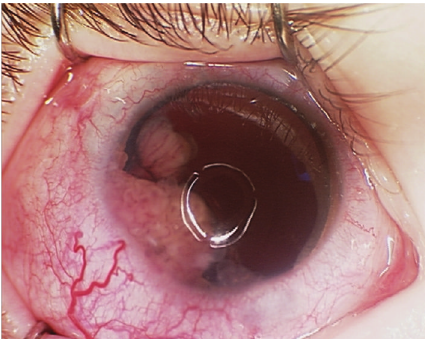
Figure 1: A solid flesh-coloured fibrovascular mass lesion was seen in the inferotemporal part of the child’s right eye. This was associated with conjunctival injection, sentinel episcleral vessel, and anterior uveitis as well as an ectropion uvea. The right eye was aphakic.